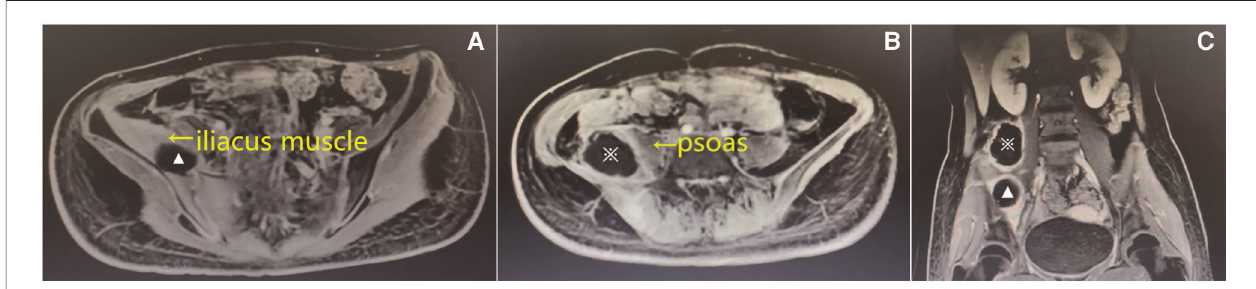
FIGURE 1 | Enhanced magnetic resonance imaging (MRI) on the 3rd admission day. Axial ( A ) and ( B ) and coronal T1-weighted images ( C ) showing that the abscesses were located in the right iliacus muscle ( ▴ ) and posterolateral to the right psoas ( ※